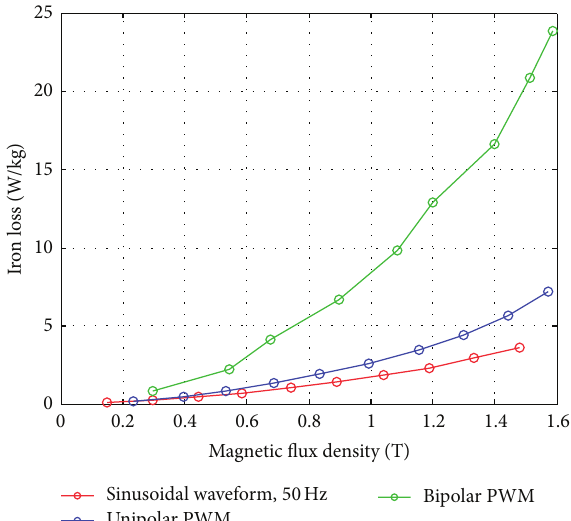
Figure 19: Iron losses for a sinusoidal waveform and PWM (with 𝑚 𝑎 = 0.3 and 𝑚 𝑓 = 20 ) obtained using the new toroidal frame.